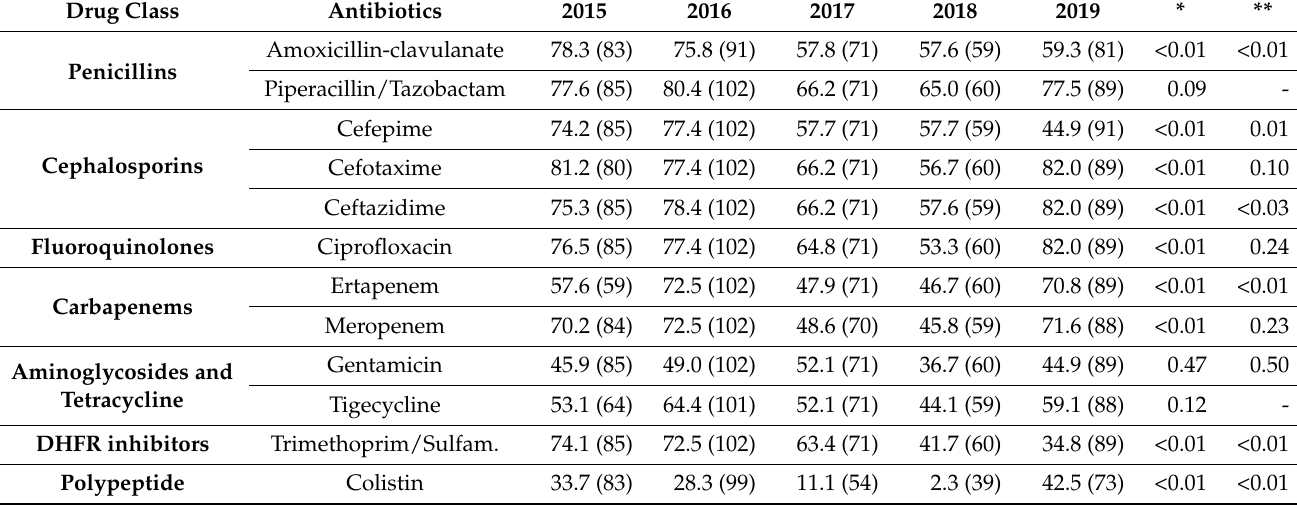
Table 8. Antimicrobial resistance profile of Klebsiella pneumoniae to antibiotics used in